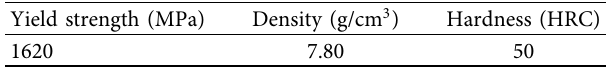
Table 2: Mechanical properties of AISI H11 steel [41].